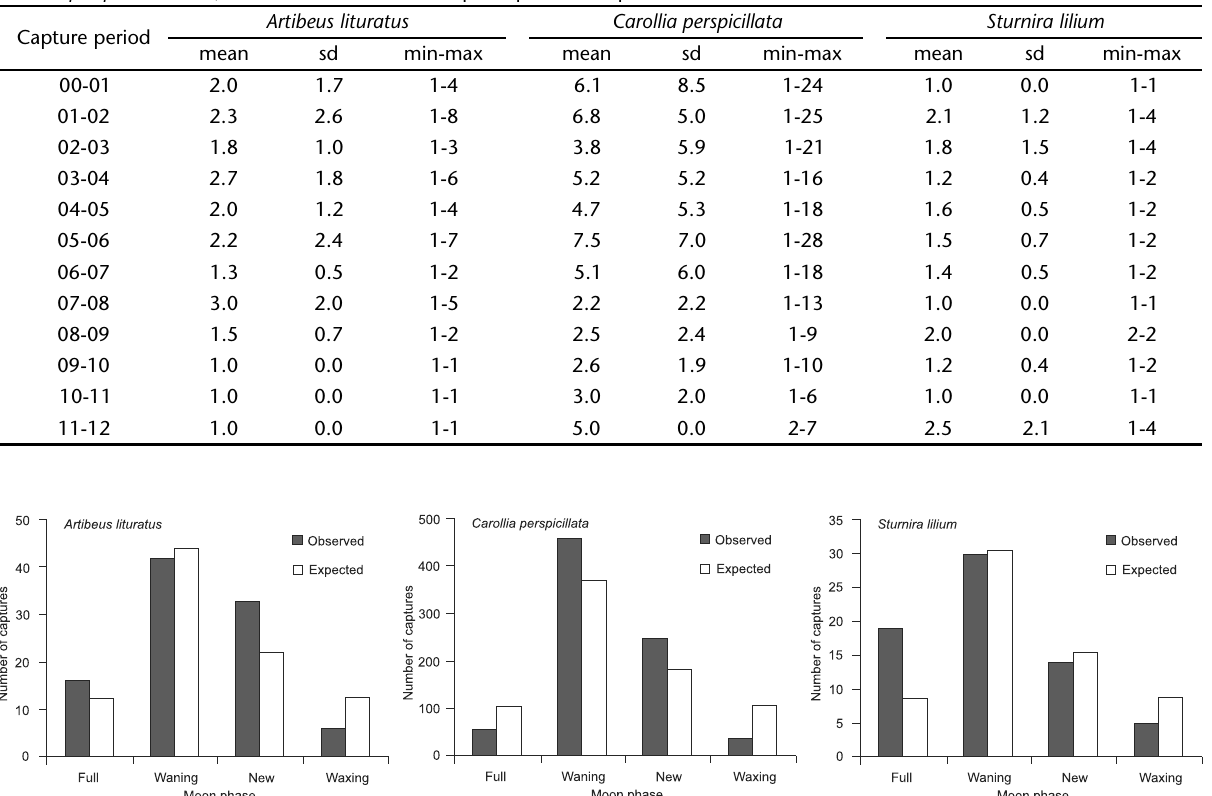
Table I. Variation in the number of captures of the bats Artibeus lituratus , Carollia perspicillata , and Sturnira lilium , in relation to one-hour periods of 29 nights, in the Poço das Antas Biological Reserve, southeastern Brazil. The number of captures of the three studied bat species was highly variable within and among nights (mean ± sd, minimum/maximum). Number of nights sampled: Artibeus lituratus = 18, Carollia perspicillata = 29, Sturnira lilium = 19. The capture period is expressed as hours after local sunset. Capture